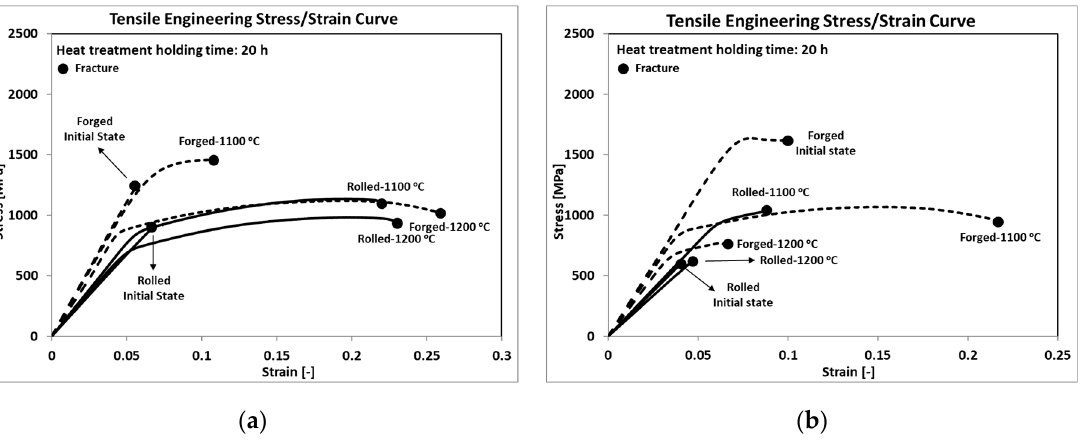
Figure 8. Tensile engineering stress-strain curves for ( a ) OP1 and ( b ) OP2.